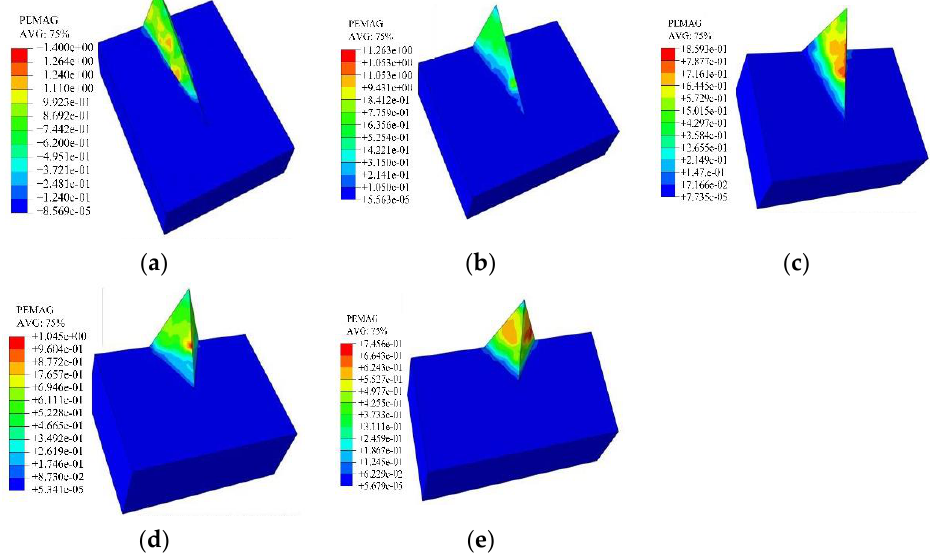
Figure 6. Cloud map of the plastic zone of ridge slope under different ridgeline inclination; (a) α =20°; (b) α =30°; (c) α =40°; (d) α =50°; (e) α =60°. ( b ) α = 30 ◦ ; ( c ) α = 40 ◦ ; ( d ) α = 50 ◦ ; ( e ) α = 60 ◦